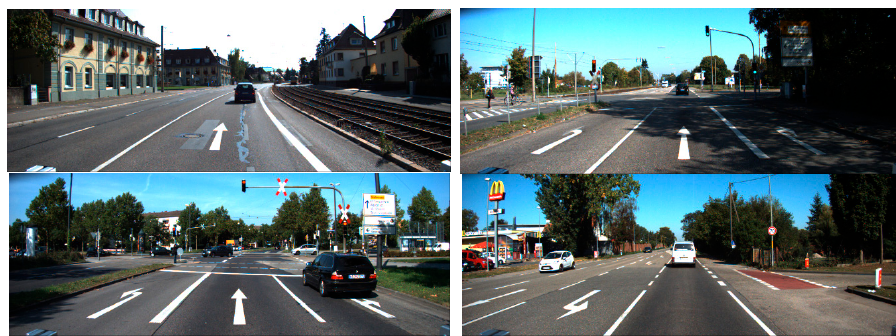
Figure 4. Example images from Karlsruhe institute of technology and Toyota technological institute at Chicago (KITTI) dataset.